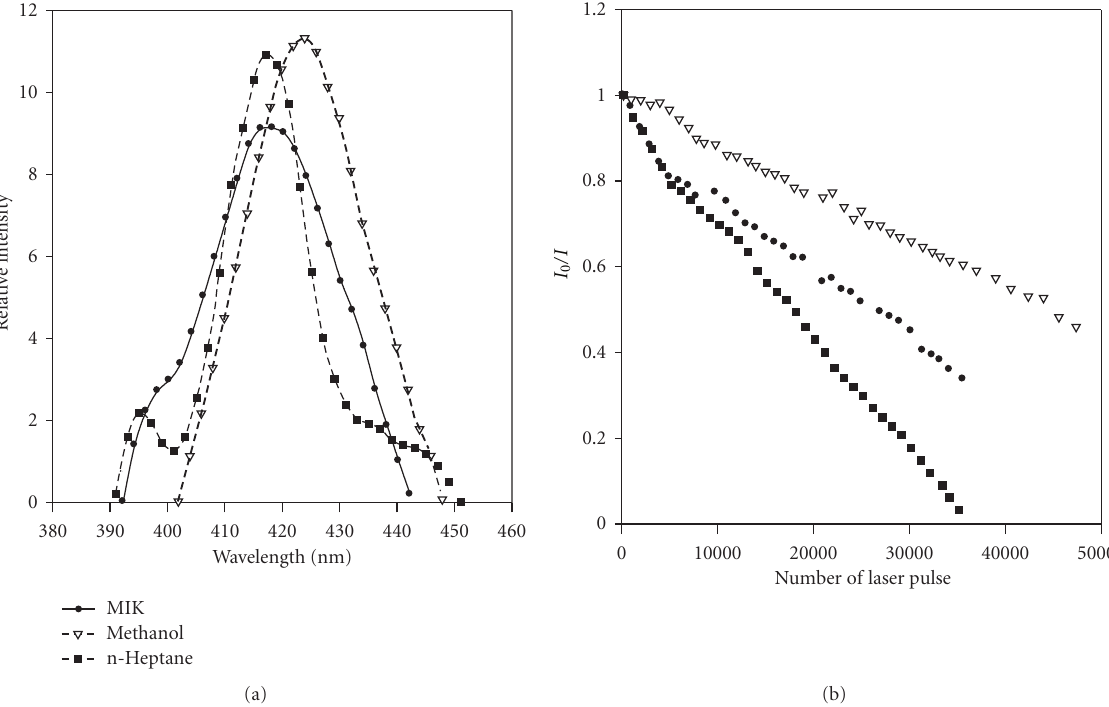
Figure 5: (a) Lasing range, (b) number of laser pulse versus ( I 0 / I ) of POPOP in di ff erent solvents using nitrogen pulsed laser ( λ = 337nm).